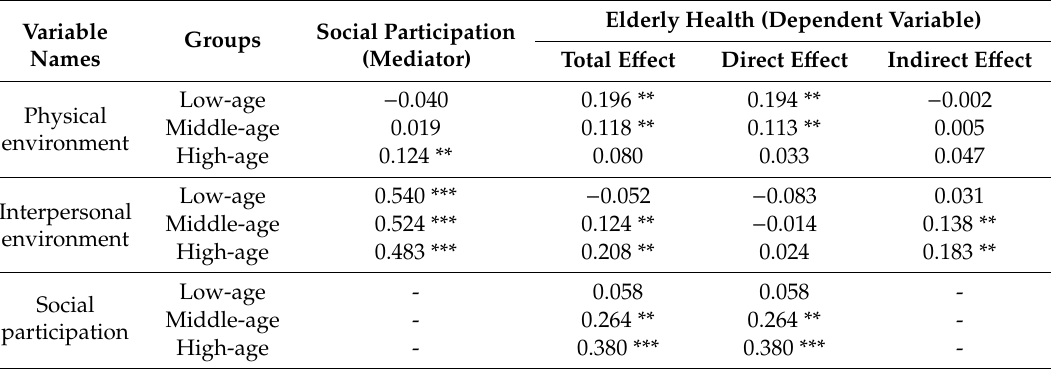
Table 4. Results of three group